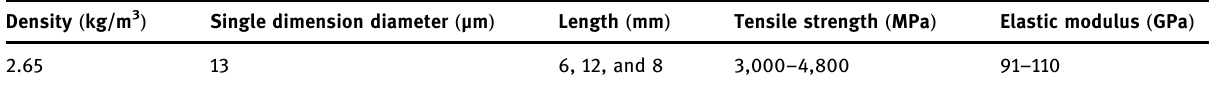
Table 3: Properties of BF